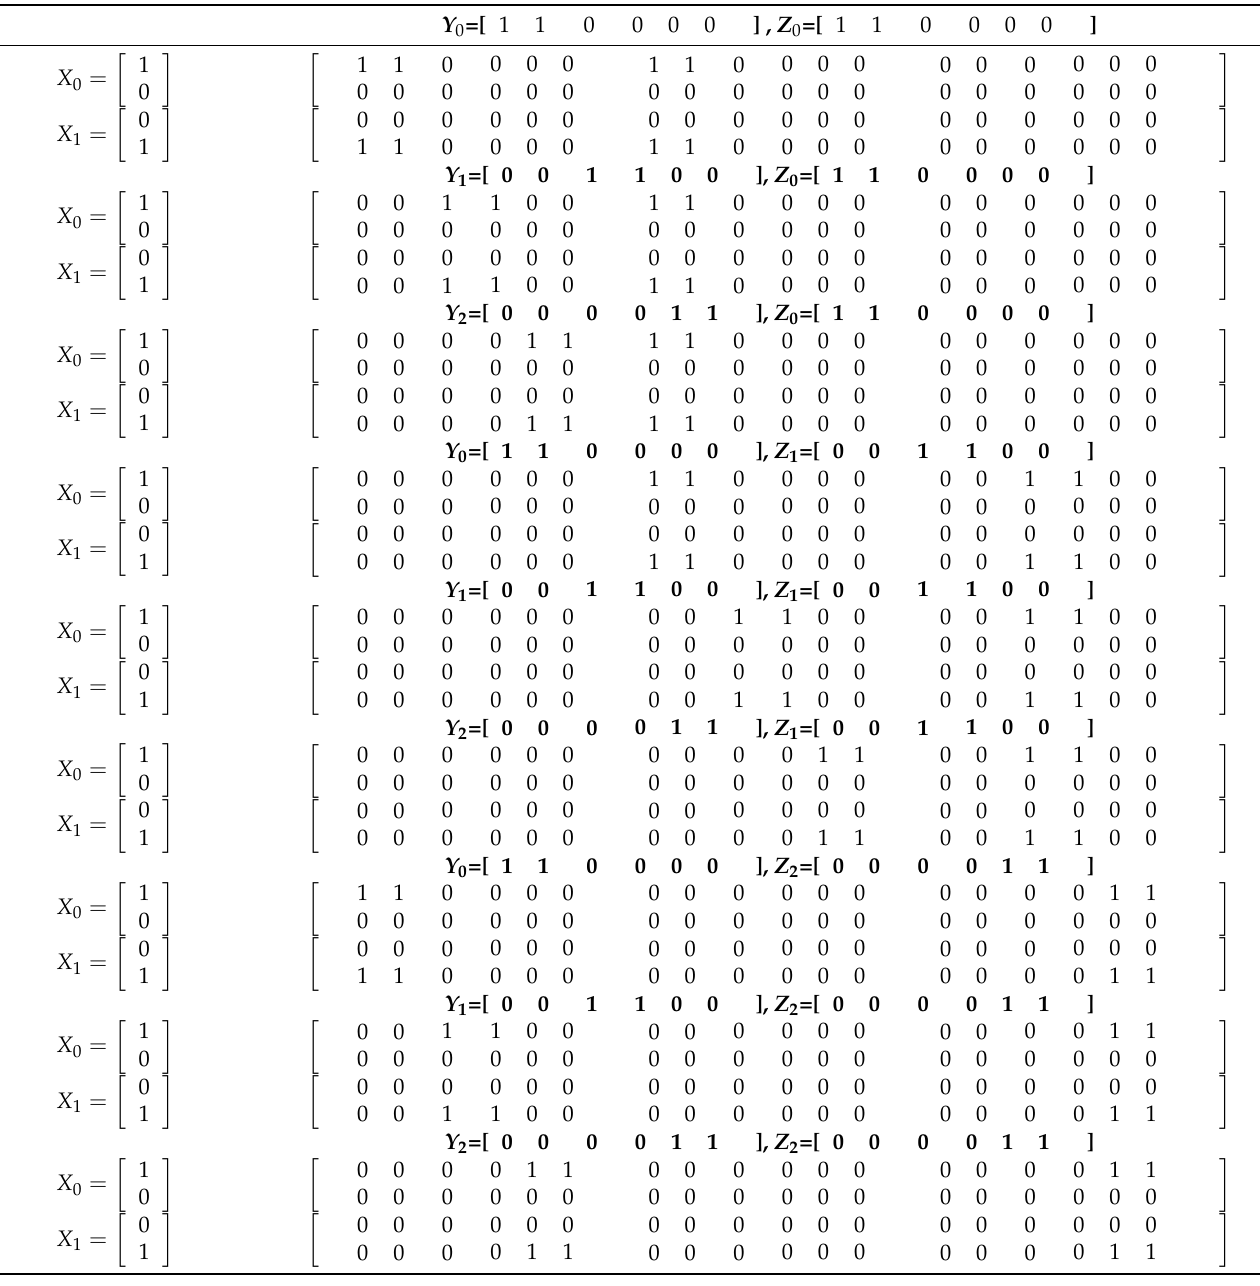
Table 3. The 3D-VWZCC code for K 1 = 2, K 2 = K 3 =